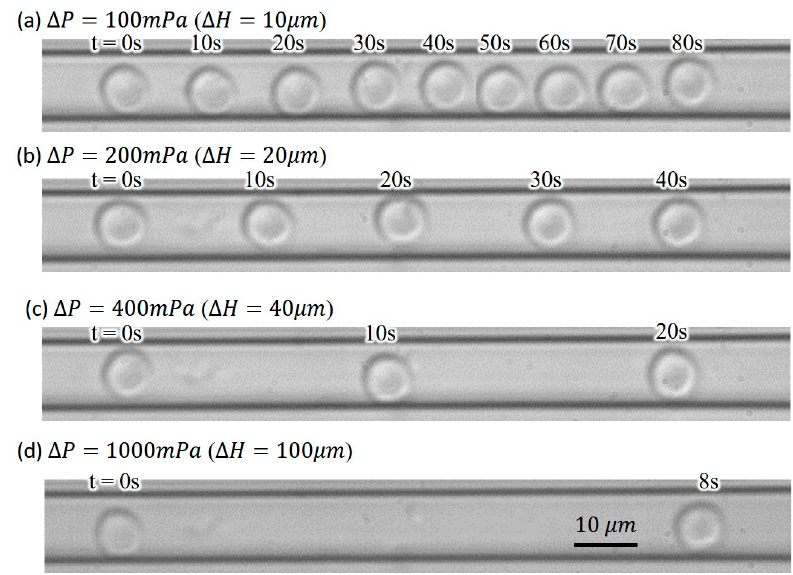
Figure 7. Series of photos of cell position with respect to time under various ( b ) ∆ H “ 20 µ m; ( c ) ∆ H “ 40 µ m; ( d ) ∆ H “ 100 µ m.